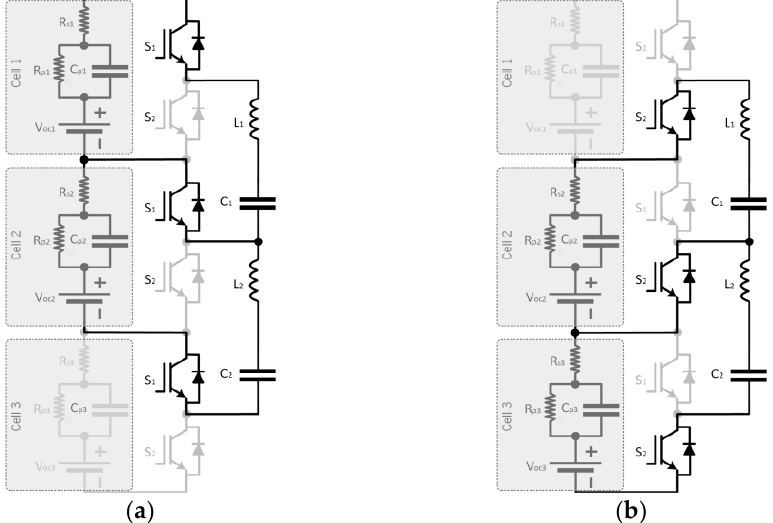
Figure 8. Operating modes of the SCI converter: ( a ) first stage, T 1 ; ( b ) second stage, T 2 .